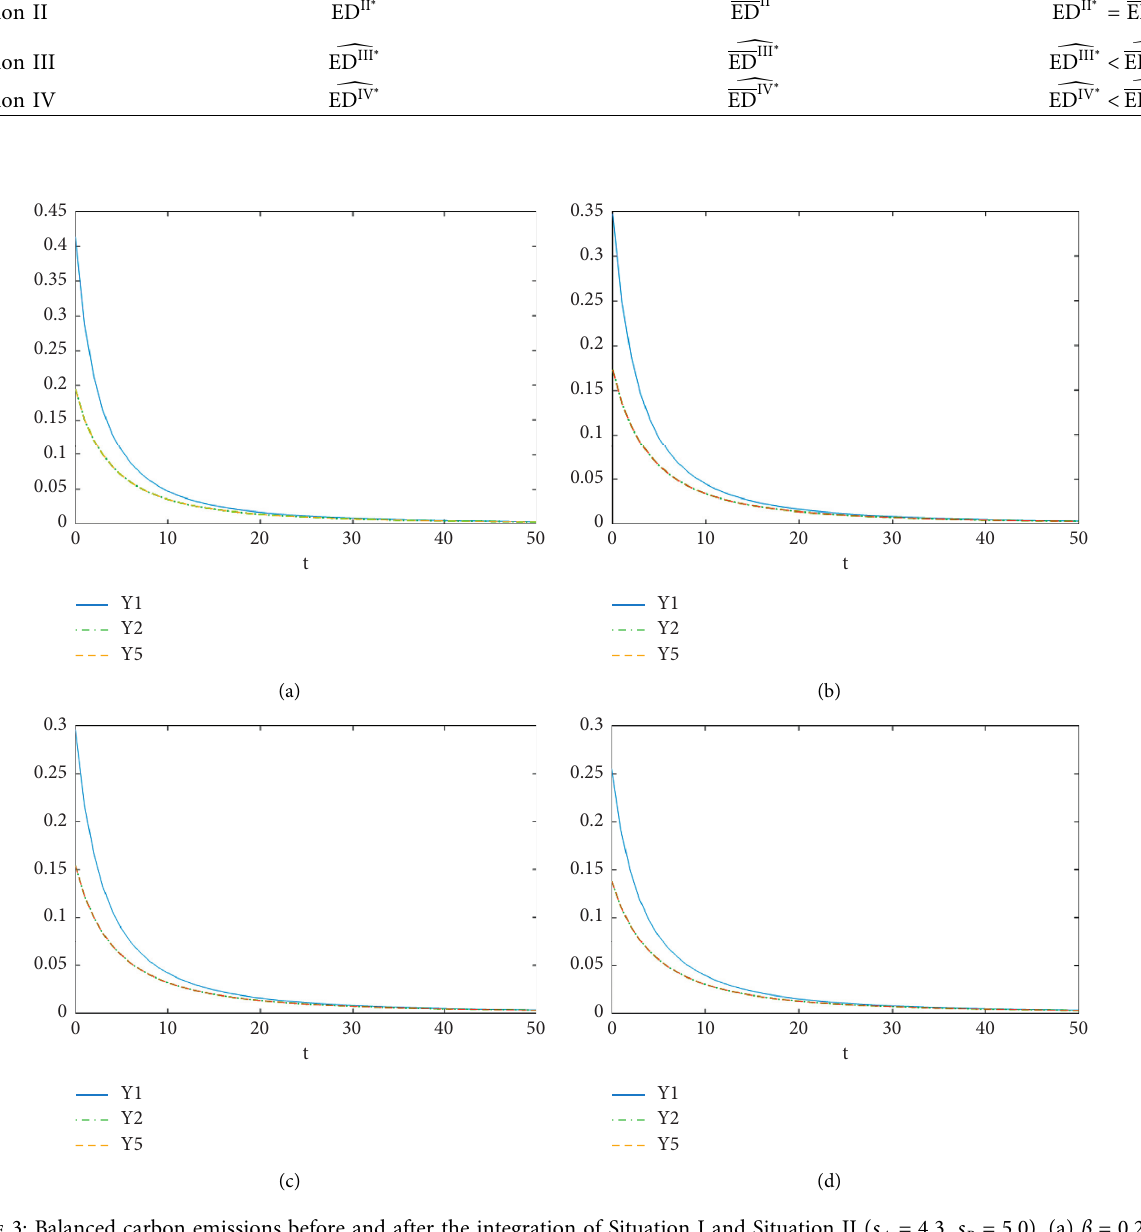
� 4 . 3, s � 5 . 0). (a) β � 0 . 2. (b) A B